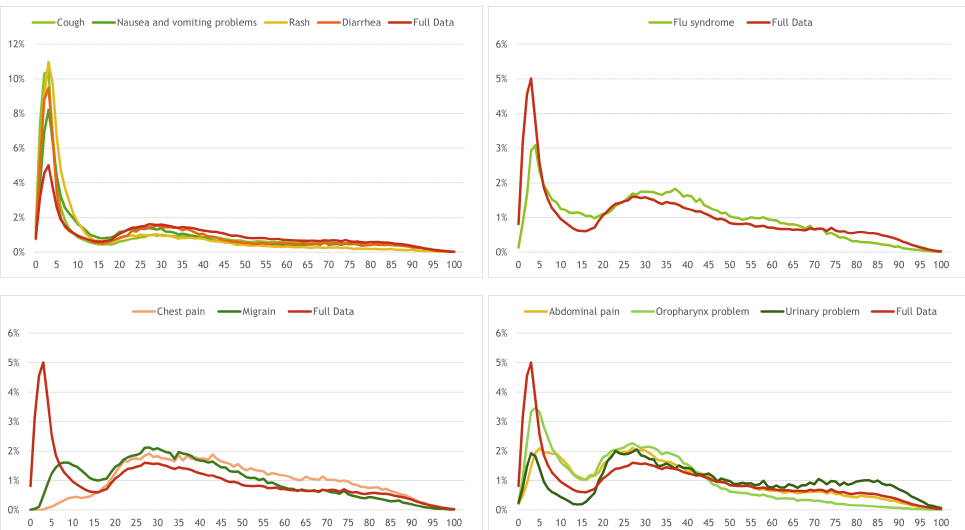
Figure 5. Distribution of calls per age for the 10 most frequent pathways (clustered by similarity).